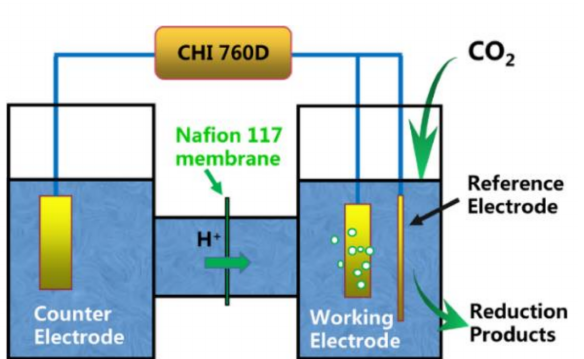
Figure 3. A schematic representation of a typical H-cell for testing CO 2 RR. Reprinted with permission from Ref. [44]. Copyright 2022 Springer